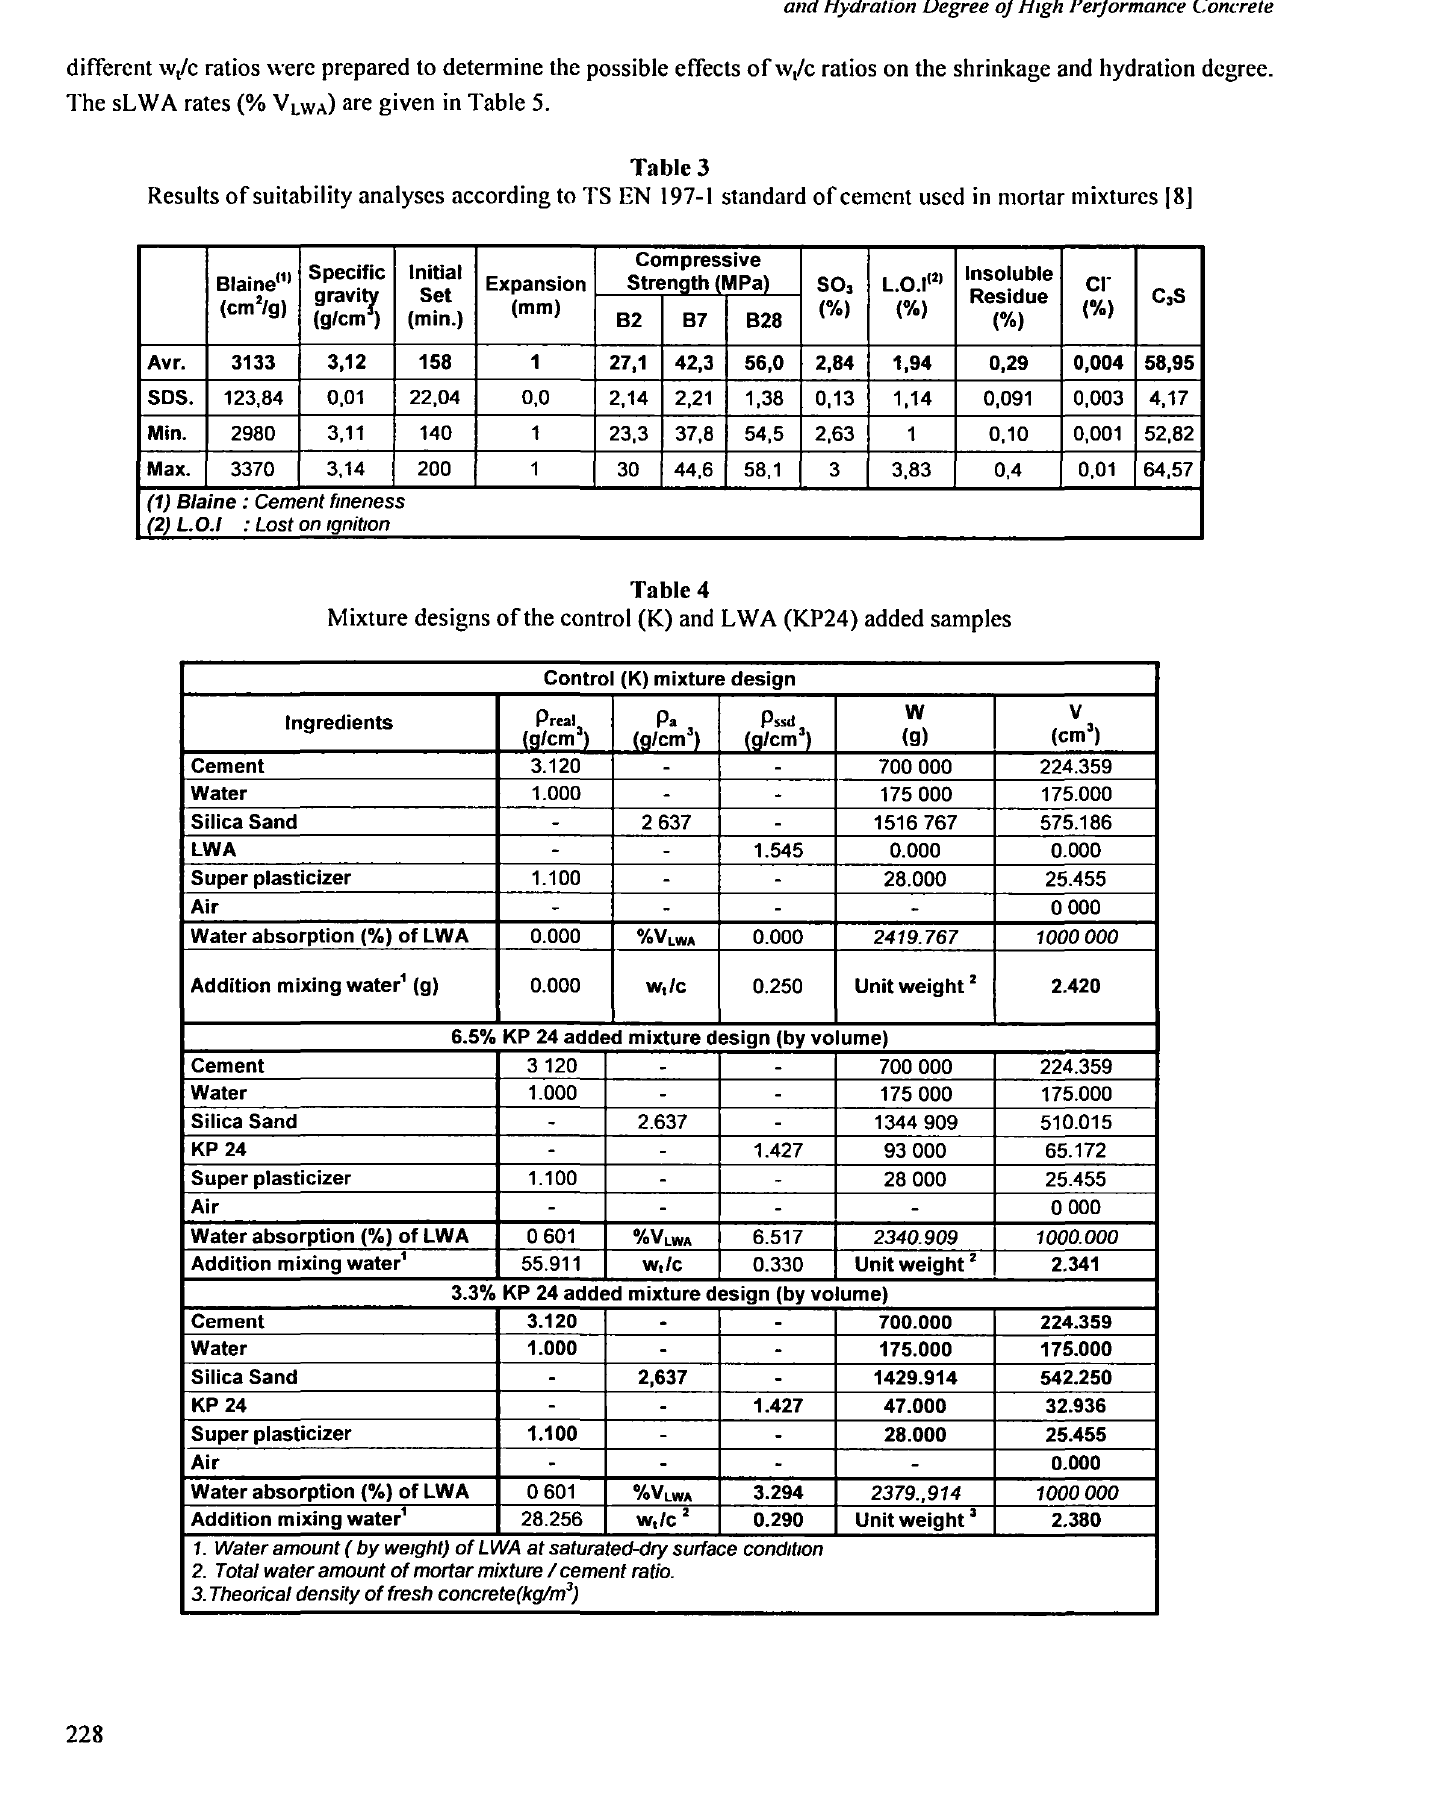
Mixture designs of the control (K) and LWA (KP24) added samples Control (K) mixture